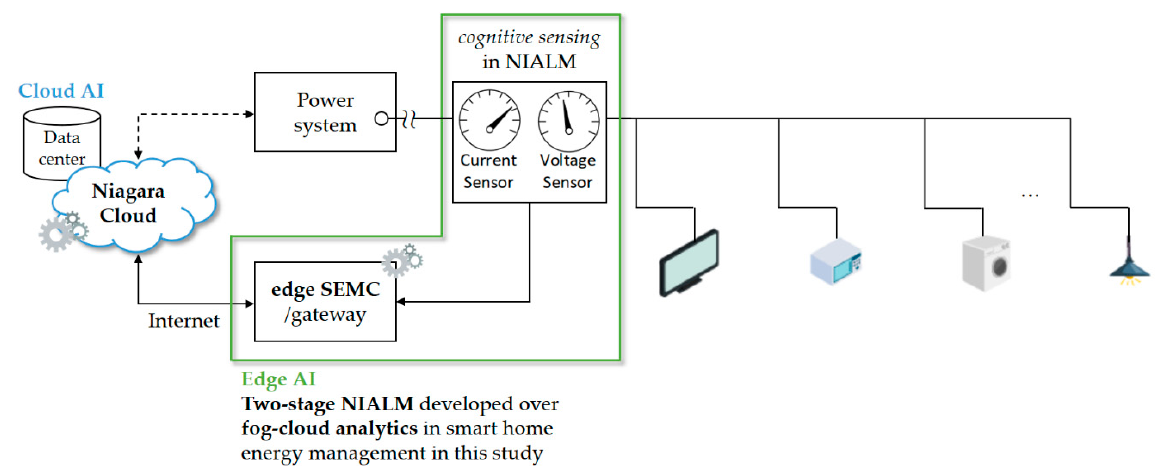
Figure 2. Developed NIALM approach over fog-cloud computing for smart home energy management in this study. Edge SEMC refers to the smart energy management controller considering edge computing.